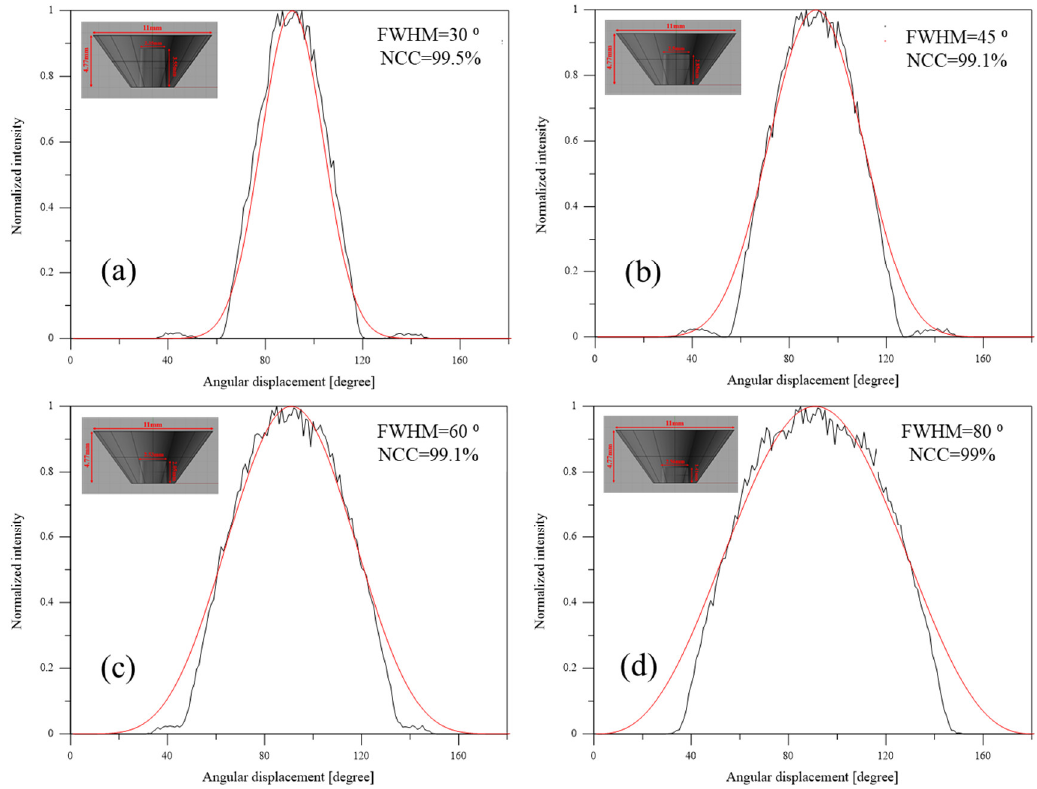
Figure 4. Designed light patterns (black line) fitted with cosine power factors (red line), for the FWHM of ( a ) 30 ° , ( b ) 45 ° , ( c ) 60 ° , and ( d ) 80 ° .